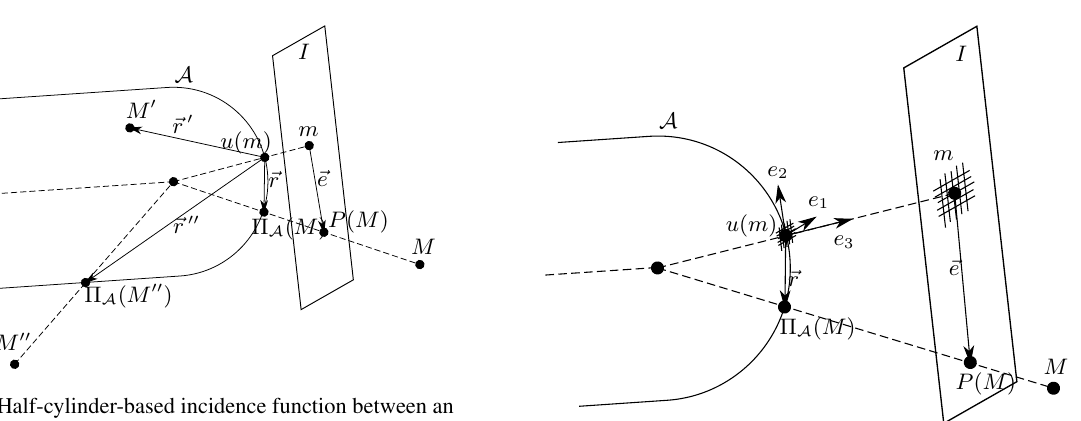
Figure 3. Half-cylinder-based incidence function between an image point m and object points in front of the camera ( M ), inside surface A ( M (cid:48) ), or behind the camera ( M (cid:48)(cid:48) ). Comparison Figure 4. Using an appropriate vector basis ( e 1 , e 2 , e 3 ) on R 3 to of the 3D incidence residual vectors (cid:126)r , (cid:126)r (cid:48) and (cid:126)r (cid:48)(cid:48) with the 2D measure the 3D incidence residual vector (cid:126)r makes it equivalent reprojection error (cid:126)e . to the pixel reprojection error (cid:126)e